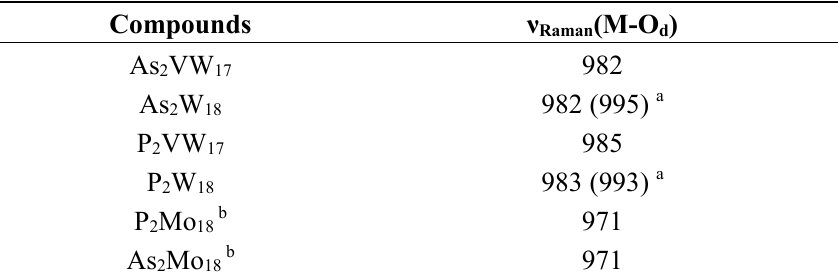
Table 1. Raman band (cm − 1 ) of As 2 VW 17 , As 2 W 18 , P 2 VW 17 , P 2 W 18 , P 2 Mo 18 and As 2 Mo 18 .